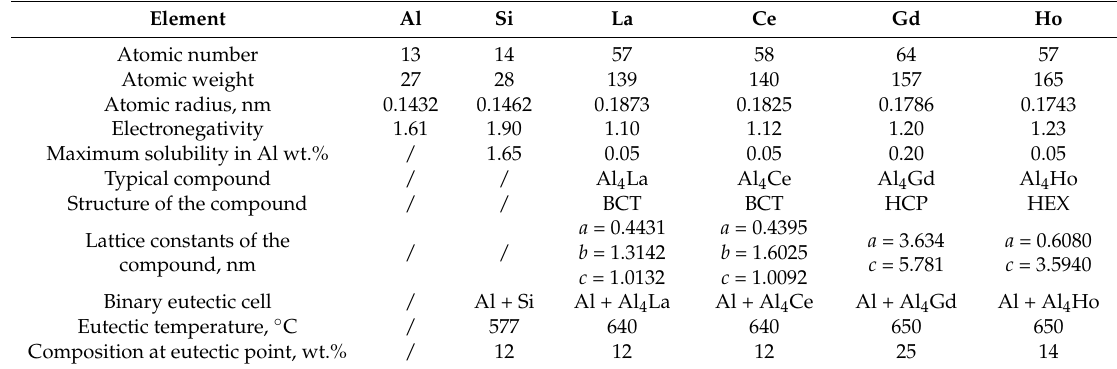
Table 1. Physicochemical parameters of the related elements and their compounds